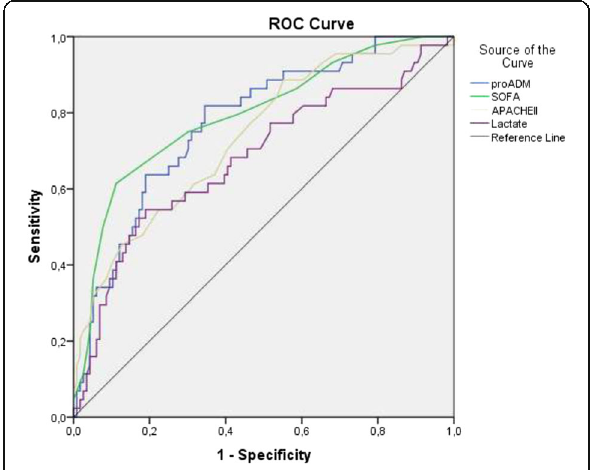
Fig. 1 (abstract 0126). AUROC for ICU mortality in overall population